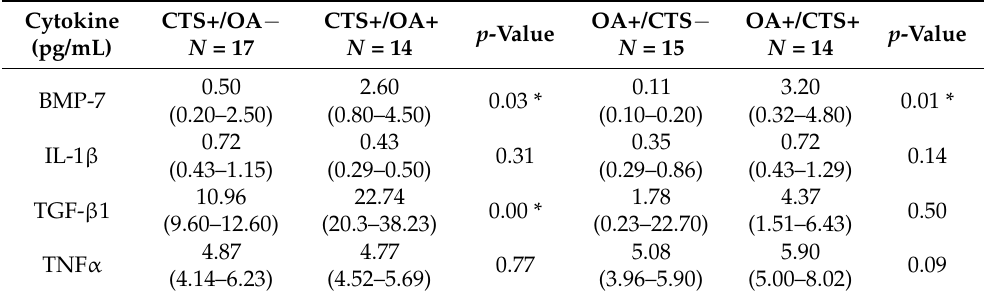
Table 3. Serum levels of inflammatory and fibrotic cytokines in CTS and OA groups of patients subdivided regarding the coexistence of skeletal